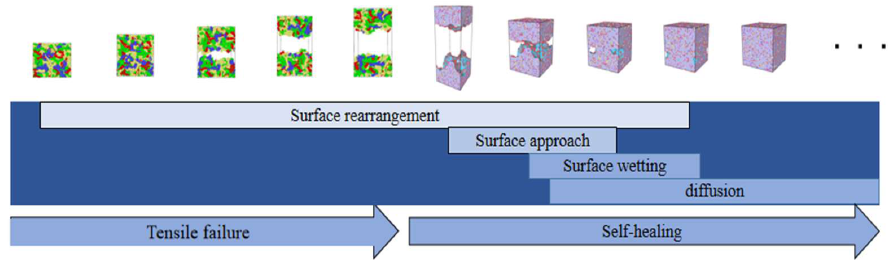
Figure 14. Distribution of self-healing stages in the “stretching-self-healing” process.